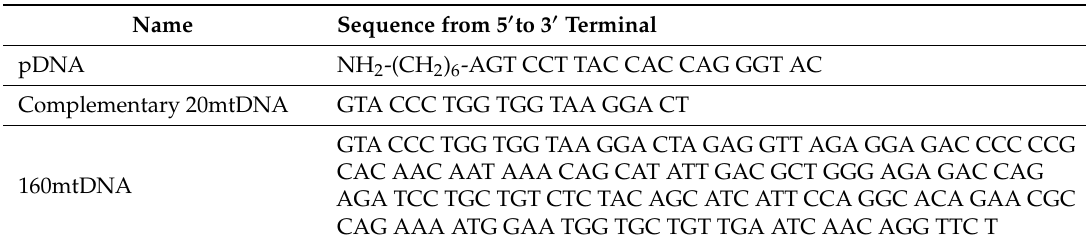
Table 1. Sequences of pDNA, 20mtDNA and